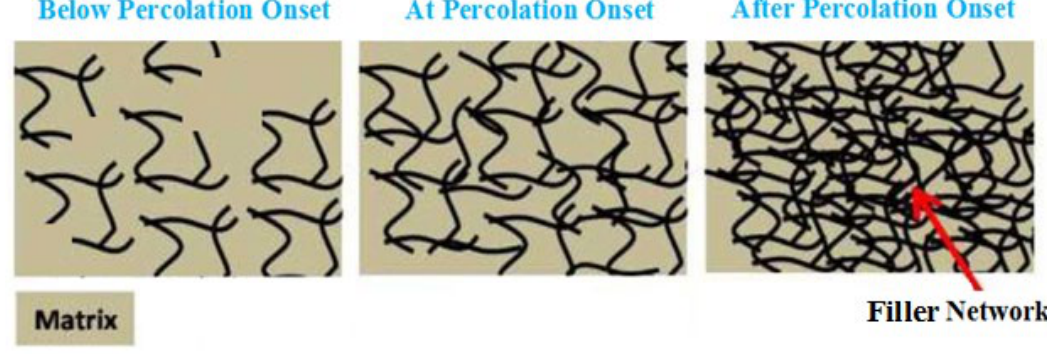
Figure 1. Schematic location of nanotubes in a nanocomposite before, during and after percolation onset.